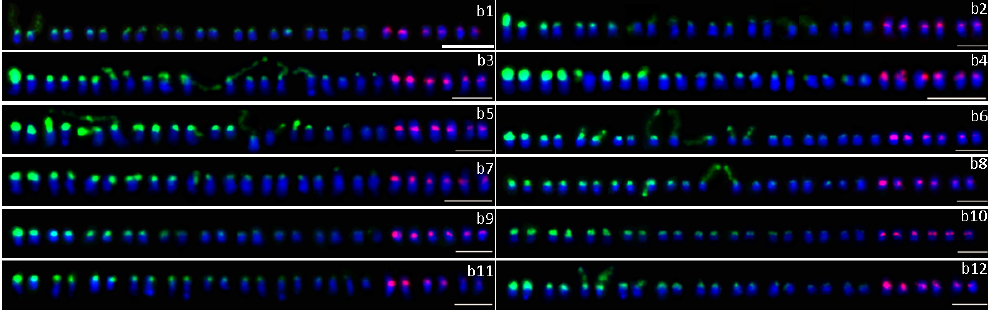
Figure 2. Distribution of 45S (green) and 5S (red) rDNA sites detected by FISH with the number